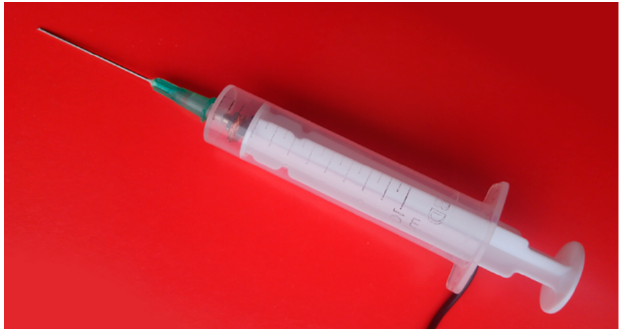
Figure 10. User’s syringe probe used to detect needle pricking into the liver phantom.